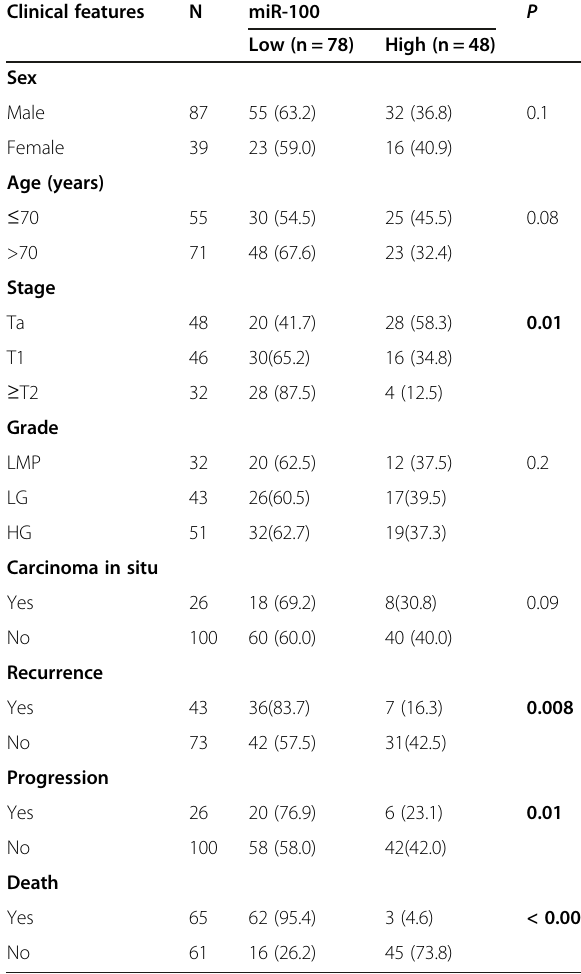
Table 2 Association between miR-100 expression and clinicopathological parameters of bladder cancer Clinical